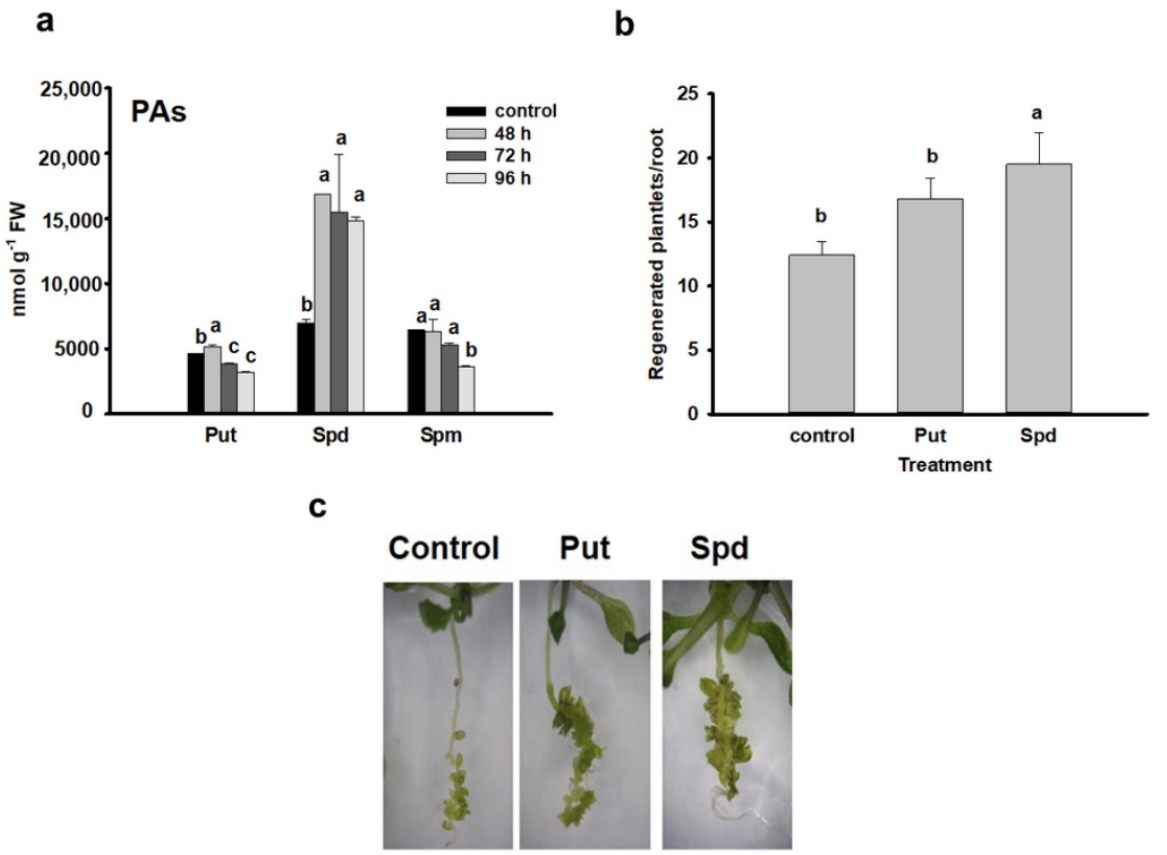
Figure 1. Polyamines are involved in the conversion of lateral root primordia into shoot meristem. ( a ) Changes in the polyamine content after 48, 72 and 96 h of cytokinin induction of Arabidopsis Scheme 48 h), and the early (72 h) and late (96 h) shoot promeristem phases [7]. ( b ) Effect of exogenously applied 100 µM spermidine and putrescine, respectively, on the efficiency of shoot regeneration of wild-type Col seedling roots determined 10 days after cytokinin induction. Images of representative seedlings are shown in ( c ). Data are means ± SE of three biological replicates with 20 technical replicates each. Different letters indicate significant differences of Duncan’s multiple comparisons ( p < 0.05).